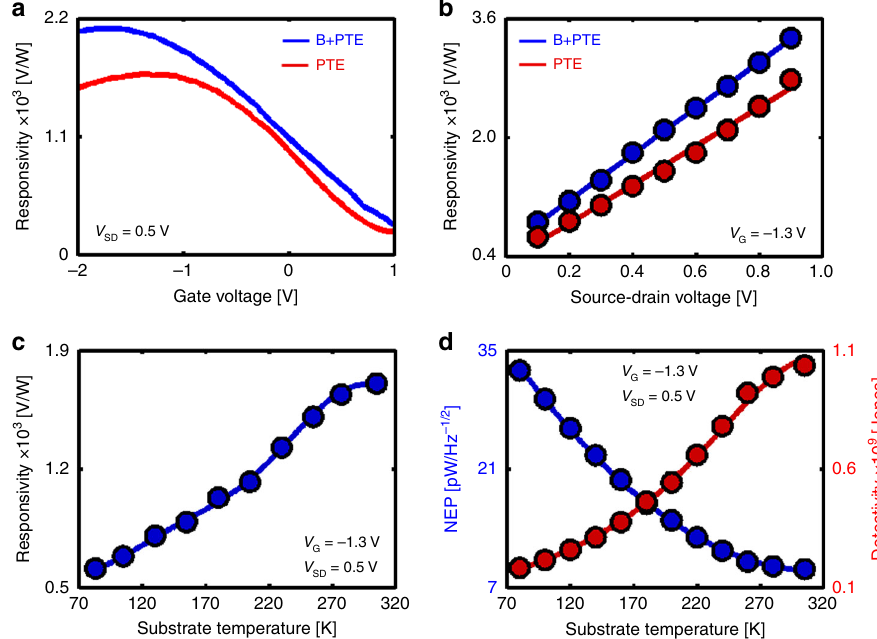
Fig. 2 D.C photoresponse results. a D.C responsivity from photo-thermoelectric (red) and combined photo-thermoelectric and bolometric (blue) effects as a function of gate voltage at room temperature and V SD = 0.5 V. b D.C responsivity as a function of bias voltage for gate voltage, V G = − 1.3 V. c D.C responsivity as a function of substrate temperature for gate voltage, V G = − 1.3 V. d The noise equivalent power (NEP) and speci fi c detectivity (D*) of the half-patterned graphene detector as a function of the substrate temperature. (B: bolometric — PTE: